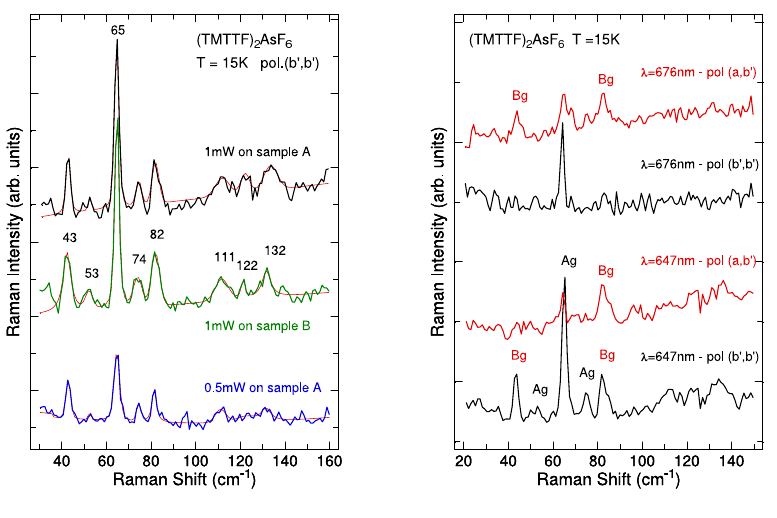
Figure 29. Left panel: λ = 647 nm Raman spectra of (TMTTF) has been reduced in order to minimize sample heating. Right panel: Polarized Raman spectra at 15 K.